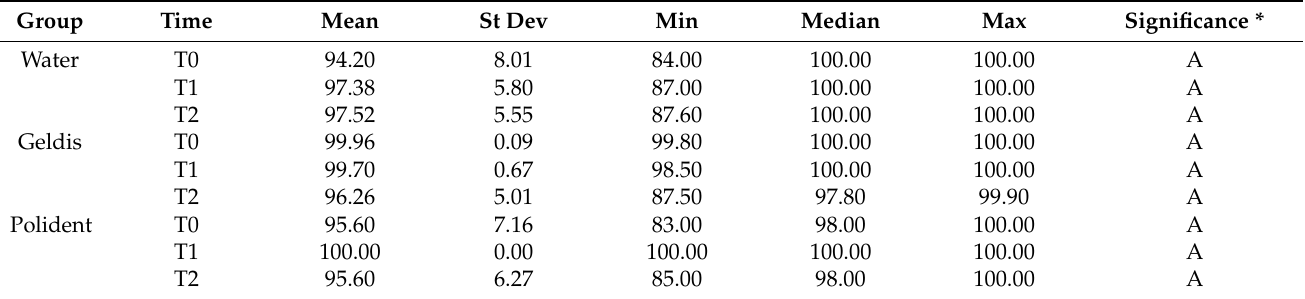
Table 6. Descriptive statistics of Total Saprophyte loads measurements.